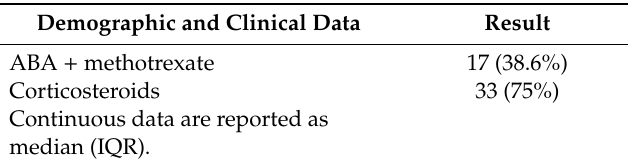
Table 1. Cont. Demographic and Clinical Data Result ABA + methotrexate 17 (38.6%) Corticosteroids 33 (75%) Continuous data are reported as median